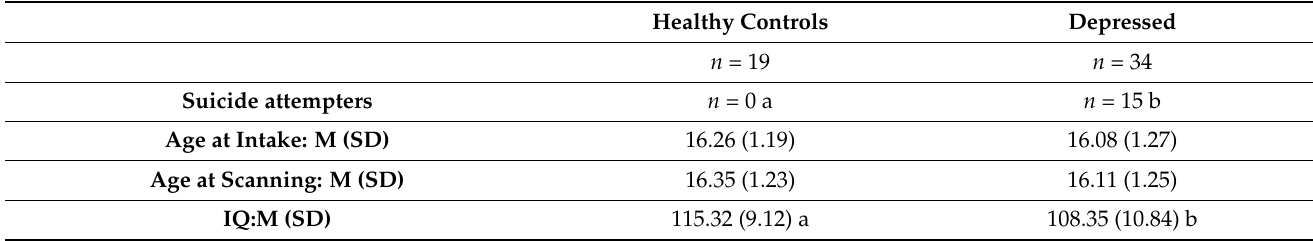
Table 1. Demographics and clinical presentation by diagnostic